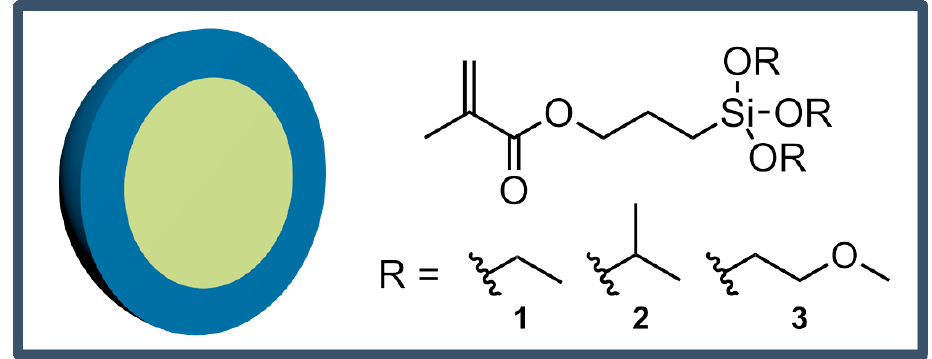
Figure 1. Particle architecture consisting of either P(MMA- co -ALMA) or P(S- co -ALMA) cores and a shell of poly(ethyl acrylate) with different alkoxysilanes as comonomers, i.e., MPSEt 1 , MPSIsoprop 2 , MPSMeEt 3 .